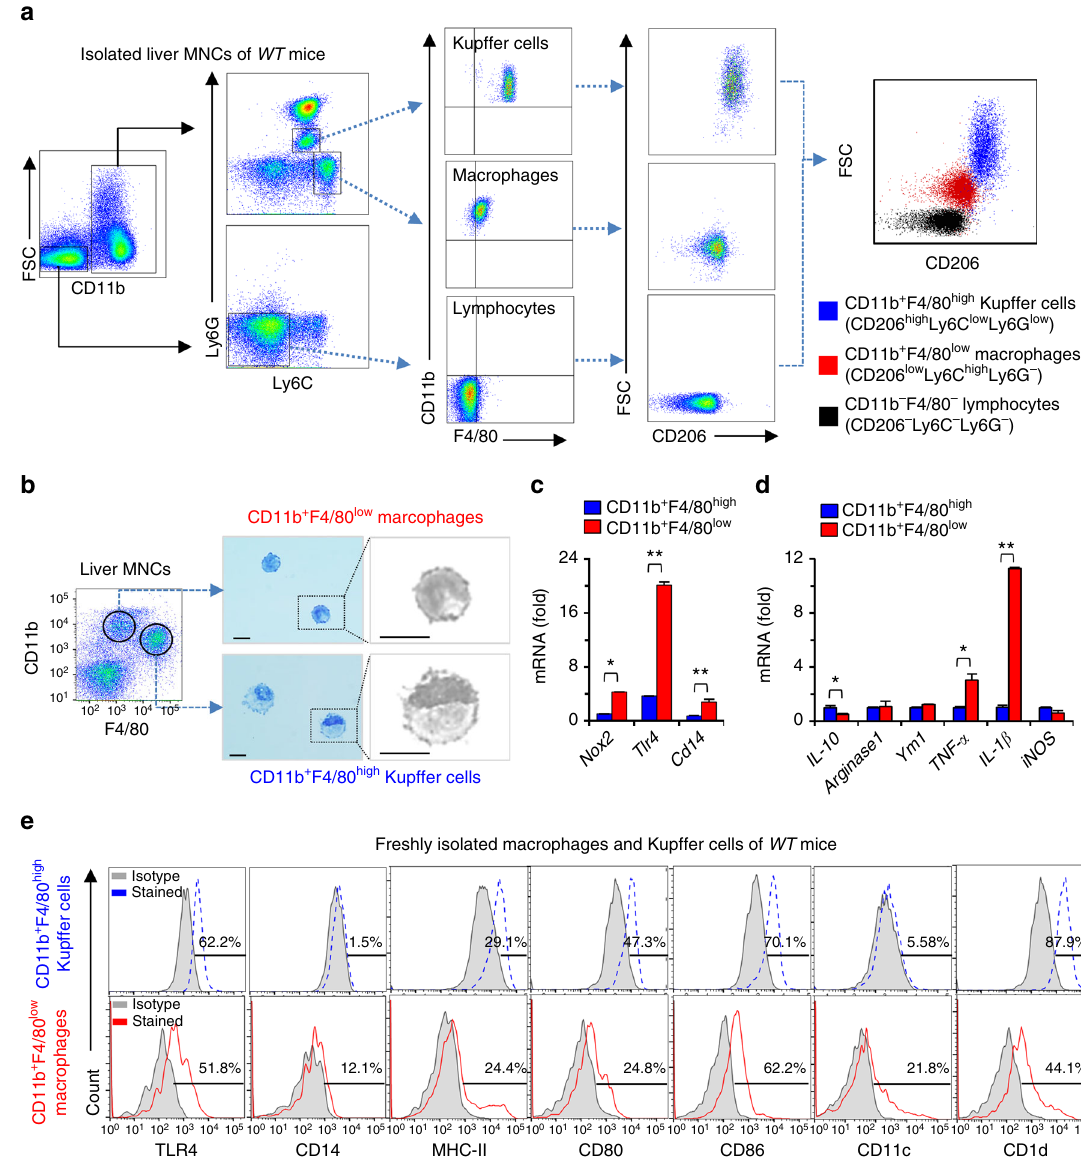
Fig. 3 CD11b + F4/80 low macrophages present a more pro-in fl ammatory phenotype than CD11b + F4/80 high Kupffer cells. a Flow cytometry analysis of freshly isolated liver mononuclear cells (MNCs) stained for monocyte lineage markers Ly6C, F4/80, CD11b and CD206 from control WT mice. Prior to CD11b + gating, singlet and live cell gating were performed. b Isolated cells were visualized by Giemsa staining. Bar = 10 μ m. c The gene expression of Nox2 , Tlr4 and Cd14 in Kupffer cells and macrophages. d Relative expression of pro-in fl ammatory genes in Kupffer cells and macrophages. e Flow cytometry analysis of CD11b + F4/80 high Kupffer cells and CD11b + F4/80 low macrophages. Percentage of surface marker expression is depicted above the histograms. Data are representative of three independent experiments in vitro using isolated liver immune cells from 3 mice per group. Data are expressed as the mean ± s.e.m. and analyzed by Student ’ s t -test, * P < 0.05, ** P < 0.01 in comparison with the corresponding